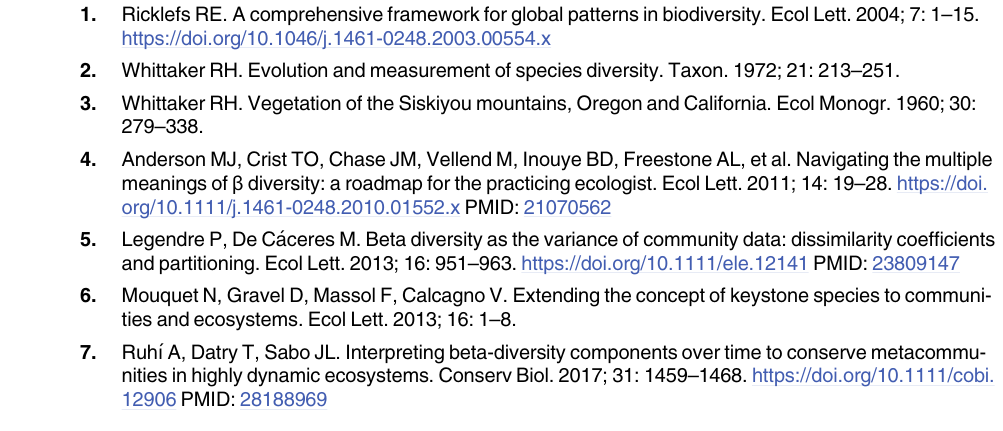
S2 Fig. Pearson correlation between richness and LCBD values during dry (a) and rainy sea- sons (b). To studied sites abbreviation see S1 Table. S1 Table. Ponds sampled during the years of 2017 and 2018 in West Brazil. S2 Table. Raw climatic variables. All temperature and precipitation values were extracted from BioClim (http://worldclim.org/current) for each studied community. All values were averaged over the surrounding 2km to help buffer uncertainty in the reported locations. Vari- ables indicates the name of the climatic variable in the respective date